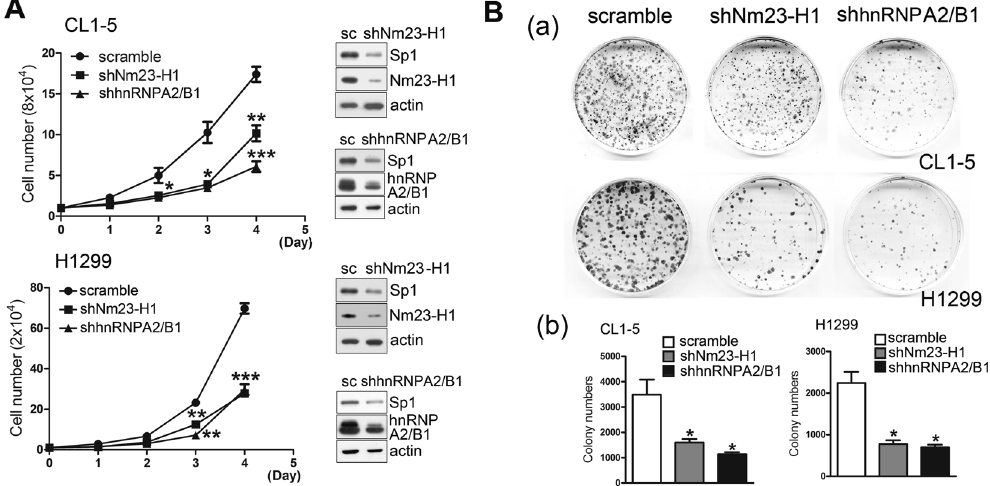
Figure 4. Nm23-H1 and hnRNPA2/B1 increase cell proliferation. ( A , B ) Nm23-H1 and hnRNPA2/B1 were silenced in CL1-5 and H1299 cell lines, respectively, for cell counting ( A ) and a colony-formation assay ( B ). After three independent experiments, the levels were quantified and statistically analysis with a t-test, * p < 0.05; ** p < 0.01; *** p <